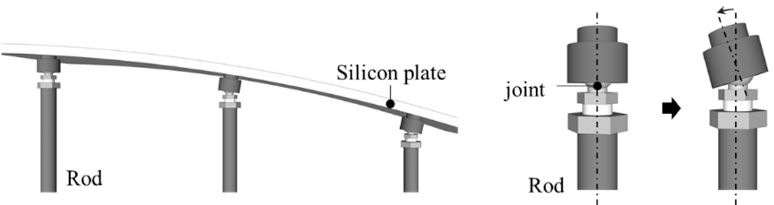
Figure 3. Joints implanted at the end of the rods to ensure the silicon plate remains smooth.